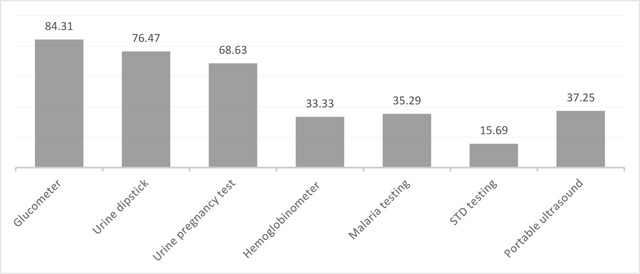
Percentage of organizations operating mobile MSTs in Latin America and the Caribbean carrying selected point of care tests (N = 48).